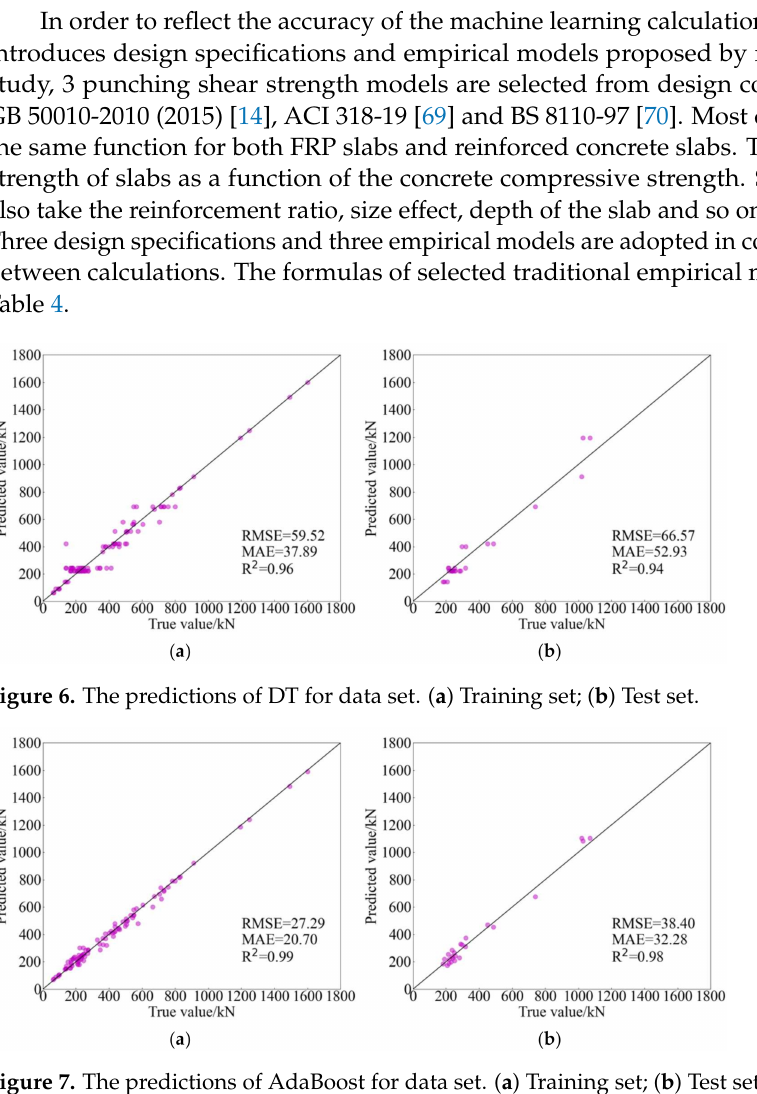
Figure 7. The predictions of AdaBoost for data set. ( a ) Training set; ( b ) Test set. Table 4. Calculation formulas of traditional empirical